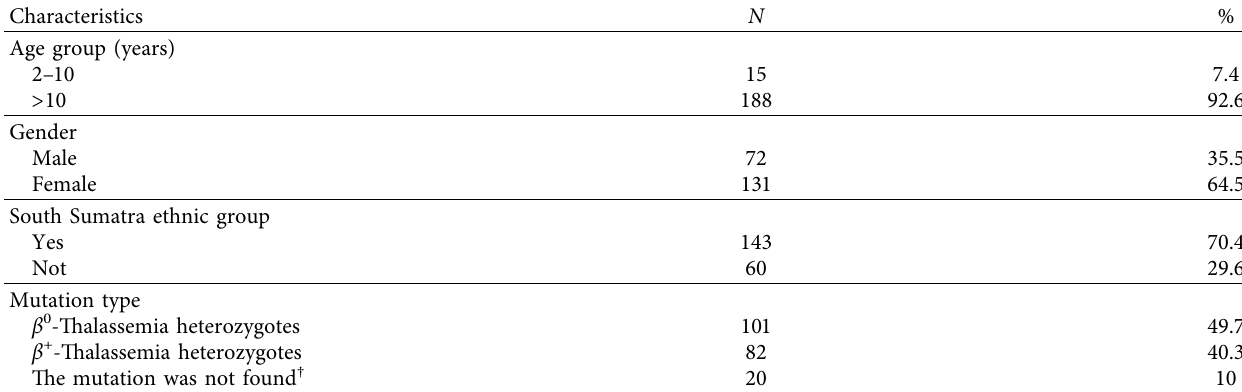
Table 1: Characteristics of the subject of the trait carrier ( n � 203).